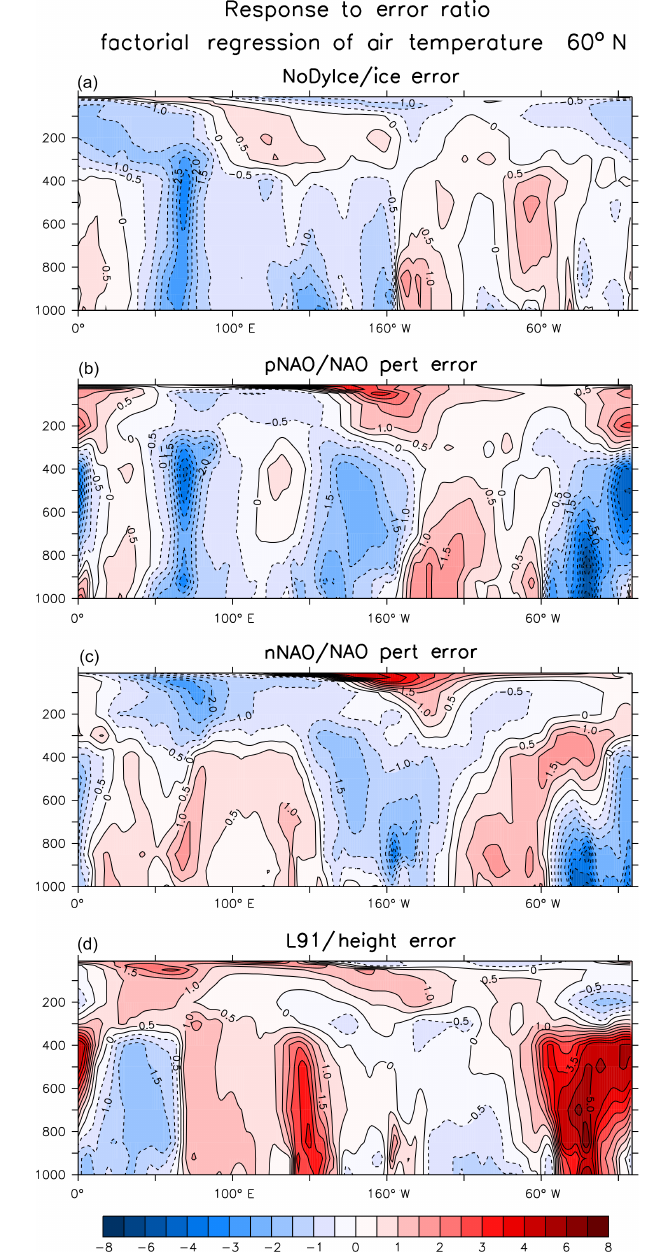
Figure 3. The ratio of the factorial regression coefficients to the er- ror estimate for different factors: (a) sea-ice representation, (b) pos- itive NAO SST perturbation, (c) negative NAO SST perturbation, and (d) the model top L91/stratosphere (bottom).